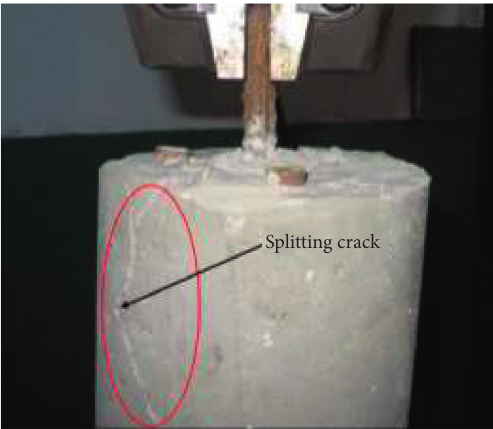
Figure 5: Splitting failure of the sample. Table 4: Failure loads of the samples